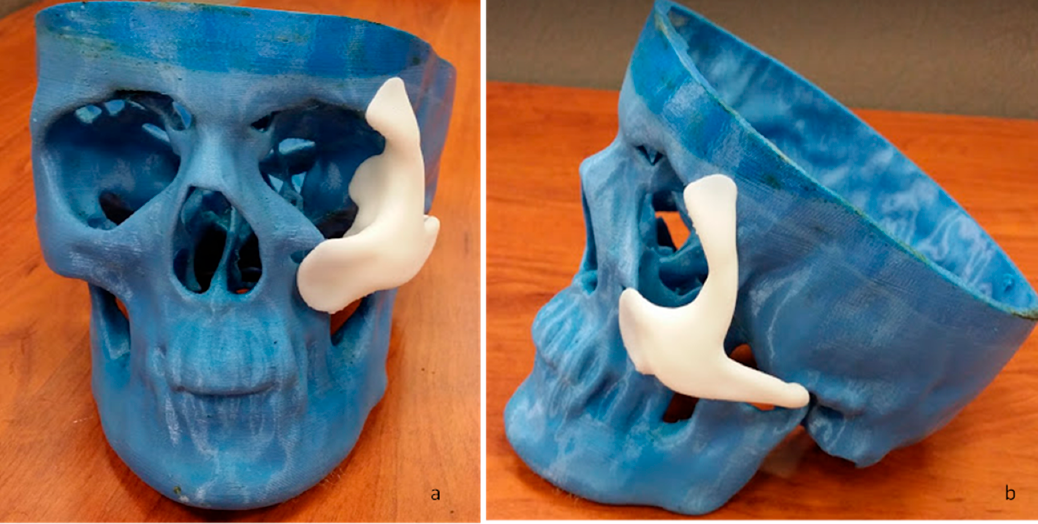
Figure 6. ( a ) FDM fabricated customized zygomatic implant fitted onto the skull model (front view); ( b ) side view illustration.